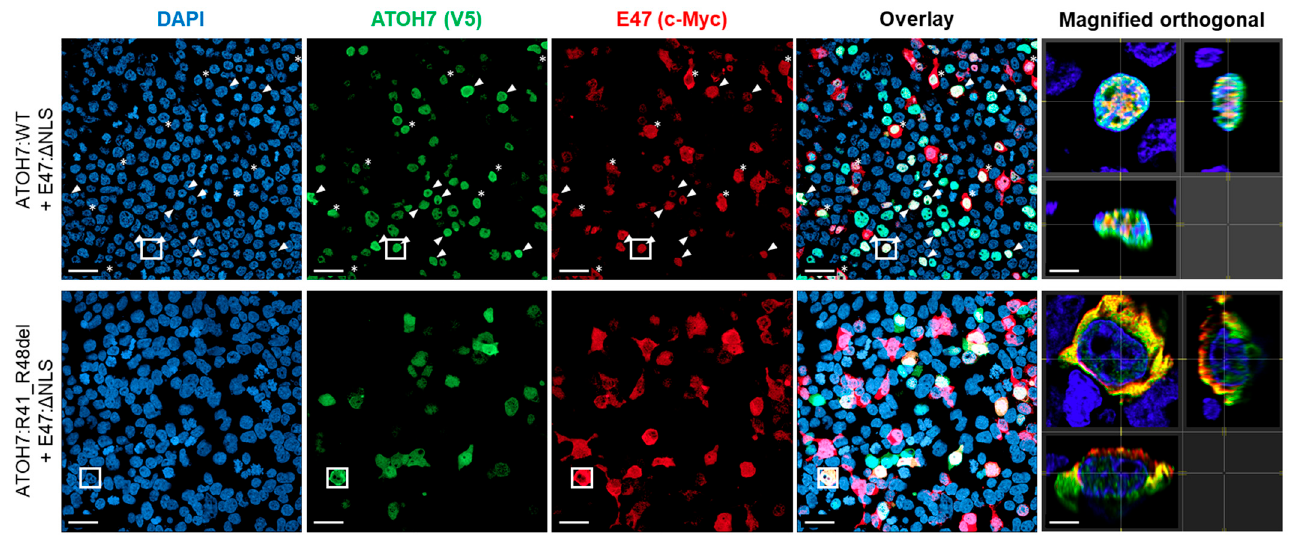
Figure 2. The mutant ATOH7:R41_R48del protein is mislocalized due to the loss of a predicted NLS within the basic domain. Confocal immunofluorescence microscopy images showing the subcellular localization of V5-tagged ATOH7 (green) and c-Myc-tagged E47 (red) proteins expressed in HEK293T cells after 4h of proteasomal inhibition by MG-132 (images without proteasomal inhibition are shown in Figure S2). Nuclei are stained by DAPI (blue). Boxes mark the position of example cells shown as XY, XZ and YZ projections (magnified orthogonal; separate channels are shown in Figure S3). Scale bars represent 30 µm (overview image) and 5 µm (magnified orthogonal). ( A ) Complete rescue of the mislocalized ATOH7:R41_R48del protein by the presence of an artificial N-terminal NLS sequence derived from the SV40 large T-antigen or by co-transfection with E47:WT, respectively. ( B ) Partial rescue of the mislocalized E47: Δ NLS variant by ATOH7:WT. Arrowheads point at co-expressing cells with complete rescue of the subcellular localization of E47: Δ NLS protein, while asterisks (*) mark co-expressing cells with no or partial rescue. ATOH7, atonal bHLH transcription factor 7; DAPI; 4 ′ ,6-diamidino-2-phenylindole; E47, transcription factor 3 isoform E47; HEK293T, human embryonic kidney 293T; NLS, nuclear localization signal; SV-40, simian vacuolating virus 40; WT, wild-type.